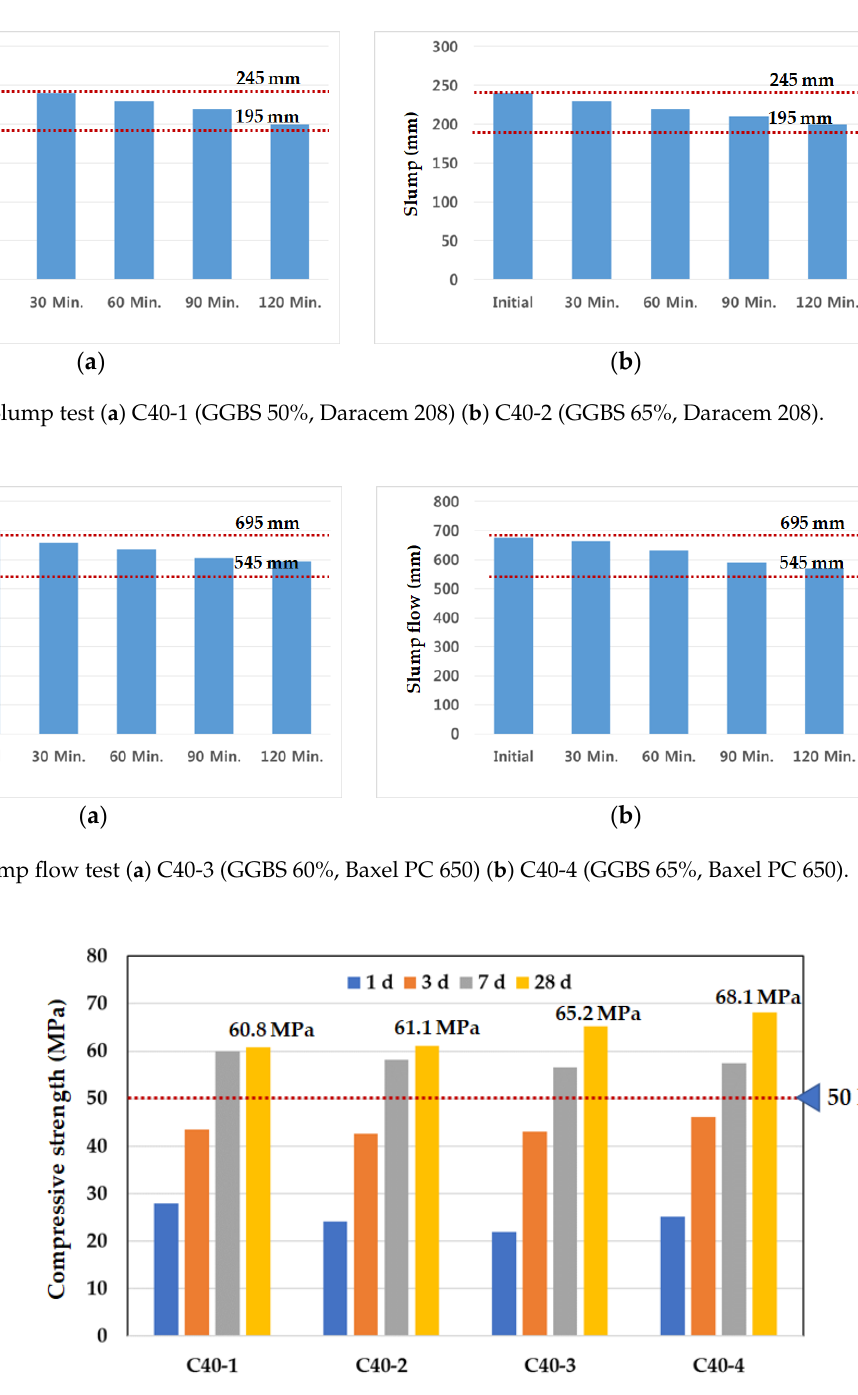
Figure 7. Compressive Strength of concrete mix design over